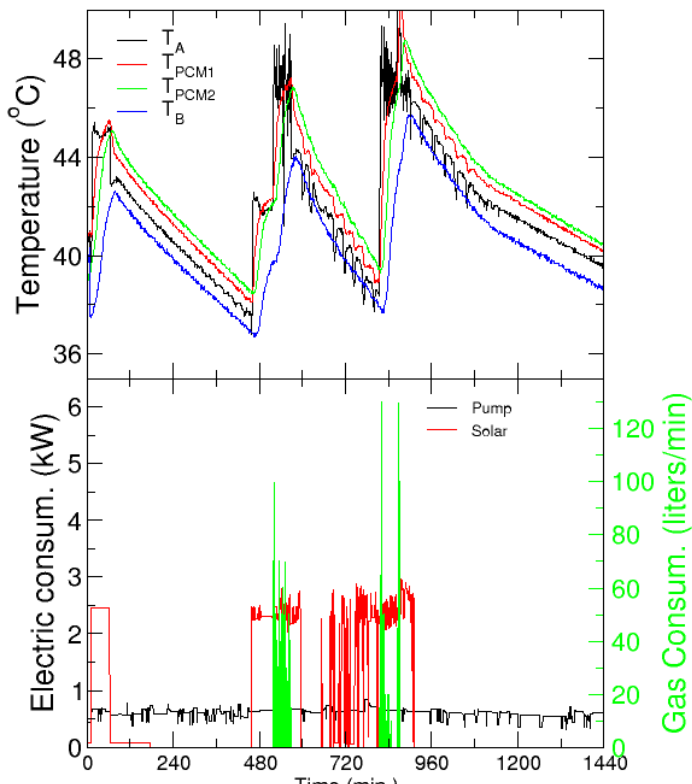
Figure 17 . Heating application. Upper panel: Evolution of the temperatures before (T A ) and after (T B ) the PCM tanks, and in the tanks. Lower panel: Electric and gas consumption as a function of solar time—left and right axis, respectively. Every charging/discharging cycle is identified by the increase/decrease of the temperature in the tanks.